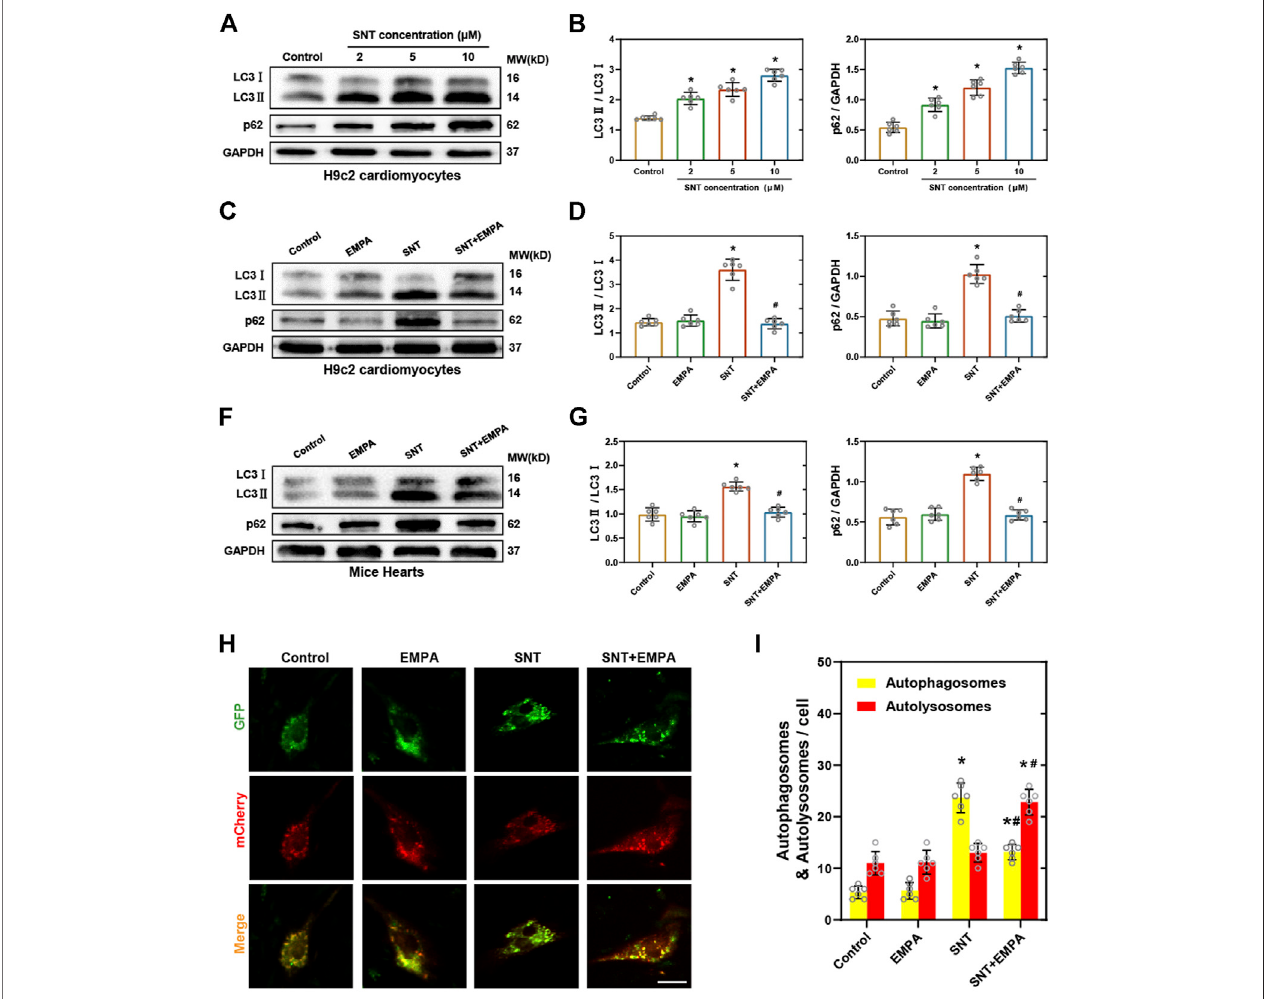
FIGURE5| EMPAreversedSNT-induced autophagicinhibition. (A) RepresentativeWesternblotsofLC3-IItoLC3-Iratioandp62inH9c2cardiomyocytestreated withdifferentconcentrationsofSNT. (B) Relativeproteinexpressionquanti fi cationofLC3-IItoLC3-Iratioandp62asillustratedin (A) , n (cid:1) 6pergroup. (C) Representative WesternblotsofLC3-IItoLC3-Iratioandp62inH9c2cardiomyocytestreatedbyvehicle,EMPA,SNT,orSNTplusEMPA. (D) Relativeprotein expressionquanti fi cation of LC3-II to LC3-I ratio and p62 as illustrated in (C) , n (cid:1) 6 per group. (E) Representative Western blots of LC3-II to LC3-I ratio and p62 in mice hearts treated by vehicle, EMPA, SNT, or SNT plus EMPA. (F) Relative protein expression quanti fi cation of LC3-II to LC3-I ratio and p62 as illustrated in (E) , n (cid:1) 6 per group. (G) Representative fl uorescenceimagesofmCherry-GFP-LC3adenovirus-transfectedH9c2cellstreatedbyvehicle,EMPA,SNT,orSNTplusEMPA. (H) Statisticalanalysis of yellow (autophagosome) and red (autolysosome) puncta per cell, n (cid:1) 6 cells per group, bar (cid:1) 20 μ m * p < 0.05 vs. control, # p < 0.05 vs. SNT.